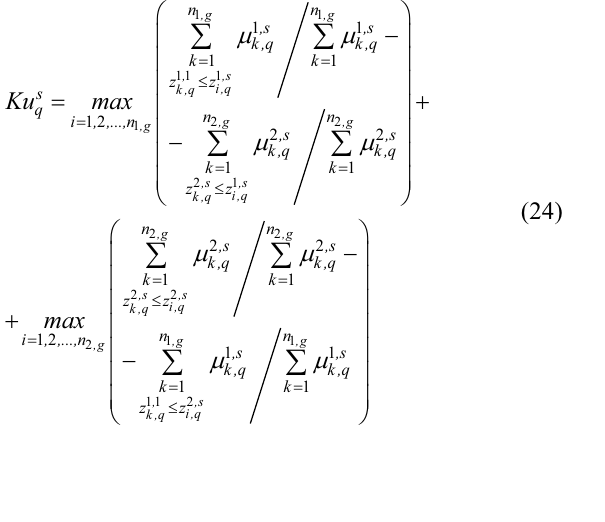
2. Select the generation method for synthetic pairs of fuzzy